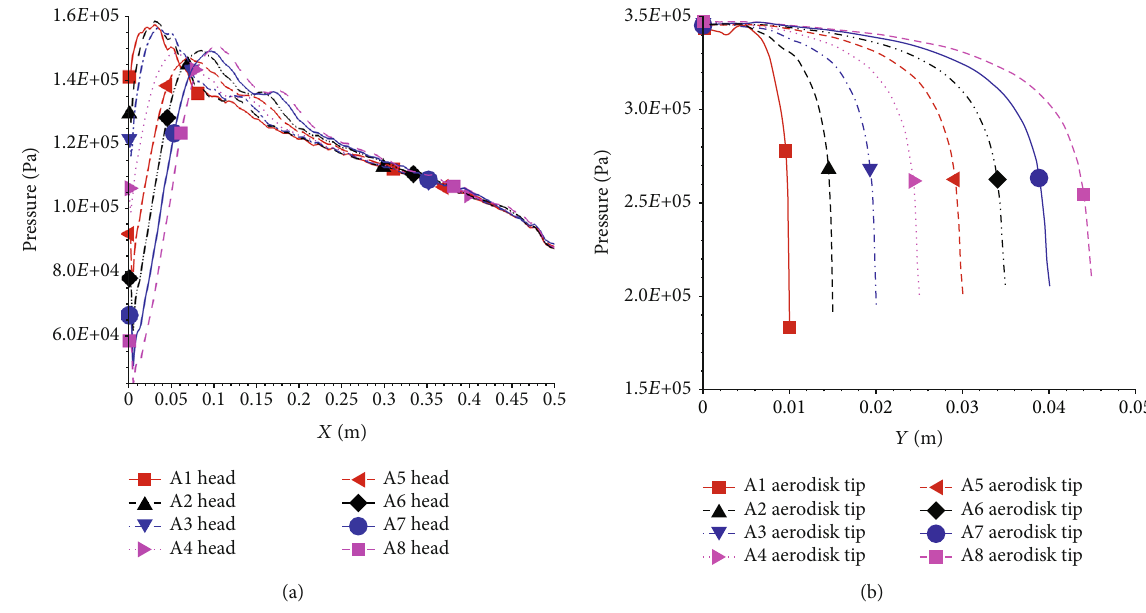
Figure 9: The head pressure curves and the pressure curves of the aerodisk tip at L = 100mm and Mach number 1.5. (a) Head pressure curves. (b) Pressure curves of the aerodisk